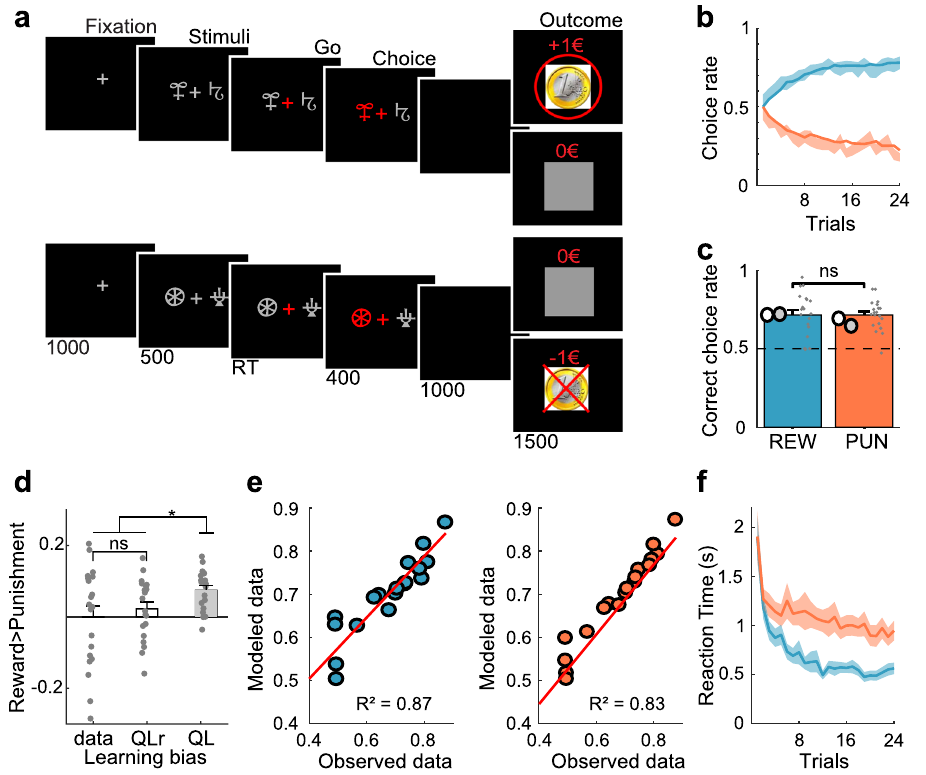
Fig. 1 Behavioral task and results. a Successive screenshots of a typical trial in the reward (top) and punishment (bottom) conditions. Patients had to select one abstract visual cue among the two presented on each side of a central visual fi xation cross, and subsequently observed the outcome. Duration is given in milliseconds. b Average learning curves ( n = 20 patients). Modeled behavioral choices (solid line) are superimposed on observed choices (shaded areas represent mean ± SEM across patients). Learning curves show rates of correct choice (75% chance of 1 € gain) in the reward condition (blue curves) and incorrect choice (75% chance of 1 € loss) in the punishment condition (red curves). c Average performance (correct choice rate, n = 20 patients). Modeled performance is indicated by white and gray disks (using Q-learning + repetition bias and basic Q-learning model, QLr and QL, respectively). Dots represent individual patients. d Difference between conditions (reward minus punishment correct choice rate) in observed and modeled data. Dots represent individual patients and error-bars represent mean ± SEM across patients ( n = 20). e Inter-patient correlations between modeled and observed correct choice rate for reward (blue) and punishment (red) learning. Each circle represents one patient. Red line represents the linear regression across patients ( n = 20). f Reaction time (RT) learning curves. Median RT are averaged across patients and the mean (±SEM) is plotted as function of trials separately for the reward (blue) and punishment (red) conditions. Black horizontal bars represent the outcome of two-sided statistical tests of difference, using paired Student ’ s t tests in c and d . ns means not signi fi cant and asterisk indicates signi fi cance in d (QL > QLr, p = 0.0037; QL > data, p = 0.013).